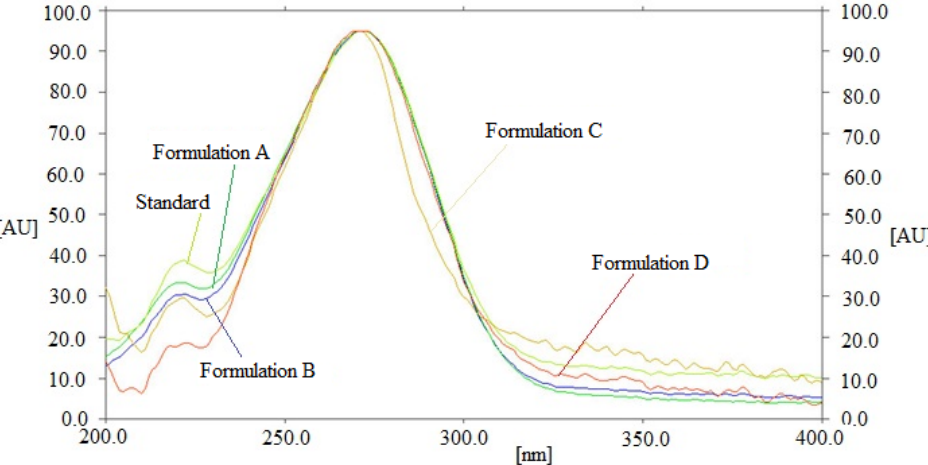
Figure 3. Superimposed UV absorption spectra of standard VD3 and various commercial formulations.